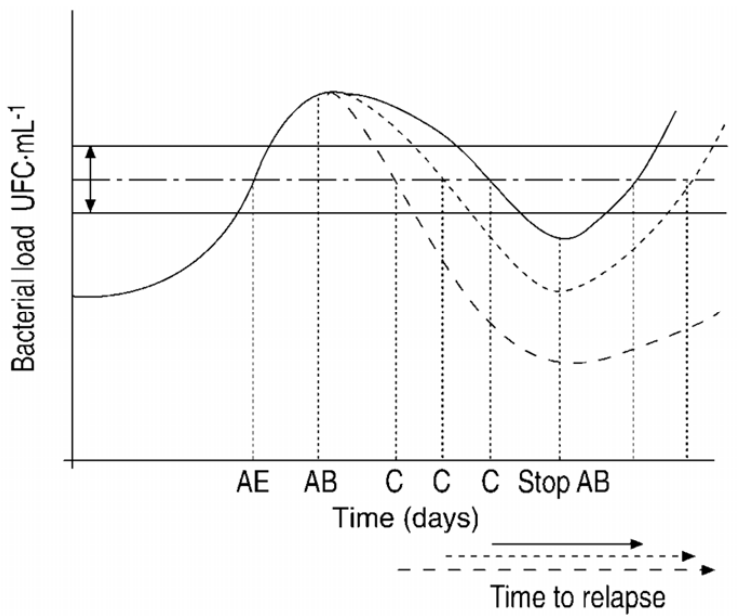
Figure 1. Areas of controversy about long ‐ term antibiotic therapy in COPD. AE: Acute exacerbation, AB: antibiotic therapy (Continuous line: AB1; short dotted line: AB2; long dotted line: AB3); C: cure; Horizontal dotted/dashed line: clinical threshold within certain limits of variability according to modifying factors (horizontal continuous lines). Under AB therapy, the concentration of PPM decreases, and when the threshold is crossed again, the clinical symptoms disappear (cure). When the intensity and speed of the bactericidal activity of the AB is increased, recovery occurs more rapidly, and the time to the next exacerbation (horizontal arrow) is lengthened. AB activity produces a “fall” in bacterial concentrations, which, if not completely eradicated after the pressure of the antimicrobial agent is removed, “rise” again. Reproduced with permission of the © ERS 2020. European Respiratory Journal 20 (36 suppl) 9s–19s; DOI: 10.1183/09031936.02.00400302 Published 1 July 2002.